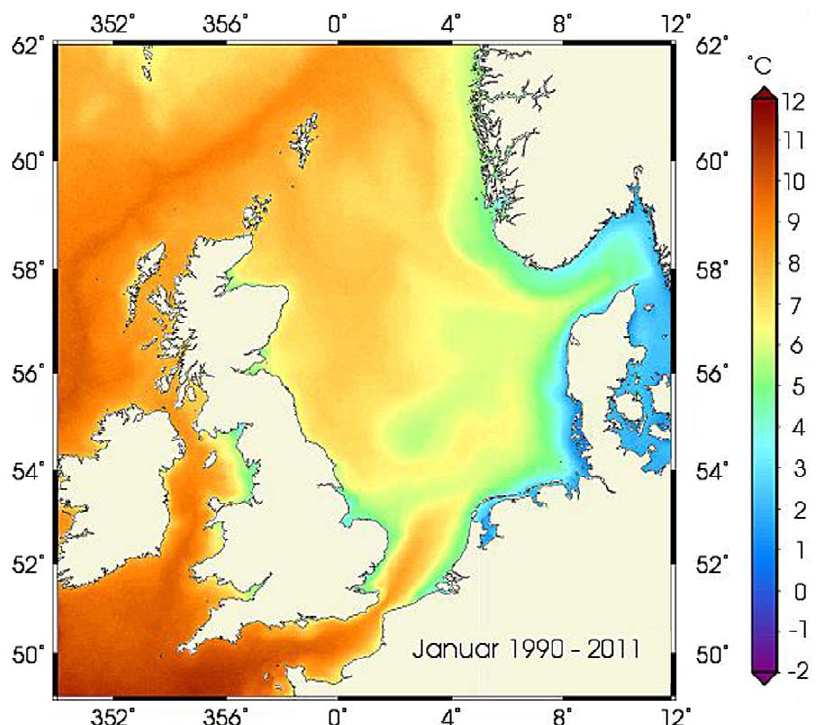
Figure 2. Map of average sea surface temperature in January 1990–2011 showing the relatively warm high-saline eastern Atlantic water flowing north-eastwards on and along the continental shelf edge, flanked by cooler water masses. Temperature measurement measured by satellite and mapped with permission from Bundesamt fu¨r Seeschifffahrt und Hydrographie, Germany (www.bsh.de).